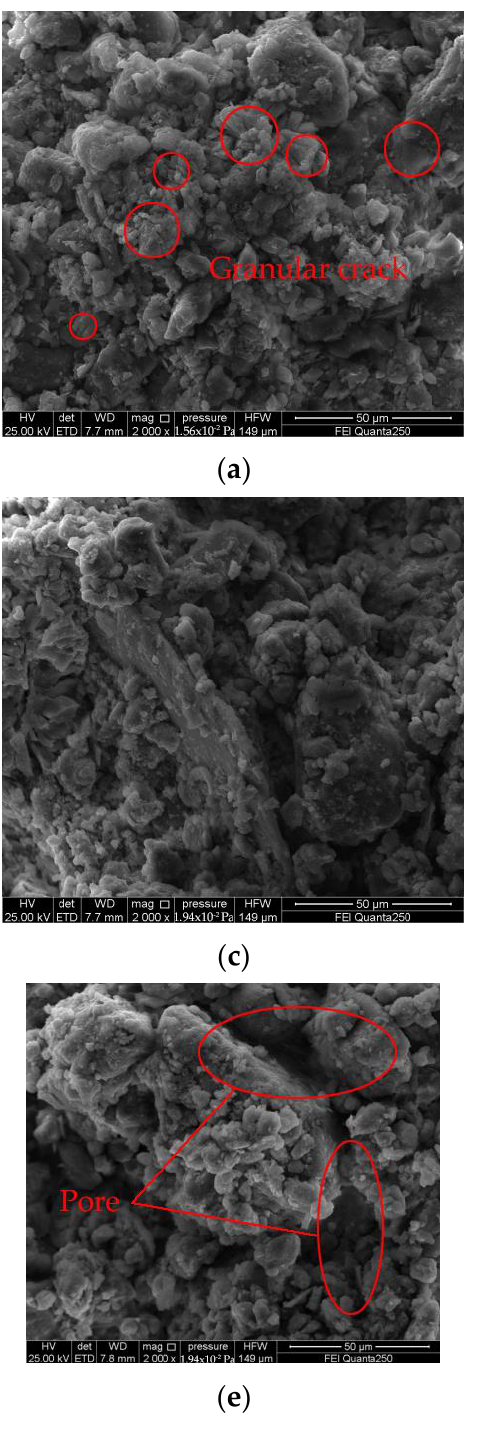
Figure 10. Scanning electron microscope: ( a ) T = 0 h, M = 20%; ( b ) T = 12 h, M = 20%; ( c ) T = 24 h, M = 20%; ( d ) T = 48 h, M = 20%; ( e ) T = 72 h, M = 20%; ( f ) T = 72 h, M = 20%.